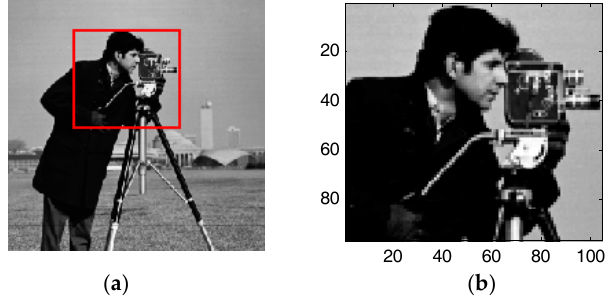
Figure 2. ( a ) the cropped Cameraman image of size (cid:1840) = 256 × 256 . ( b ) the selected image portion of size (cid:1840) = 96 × 104 .